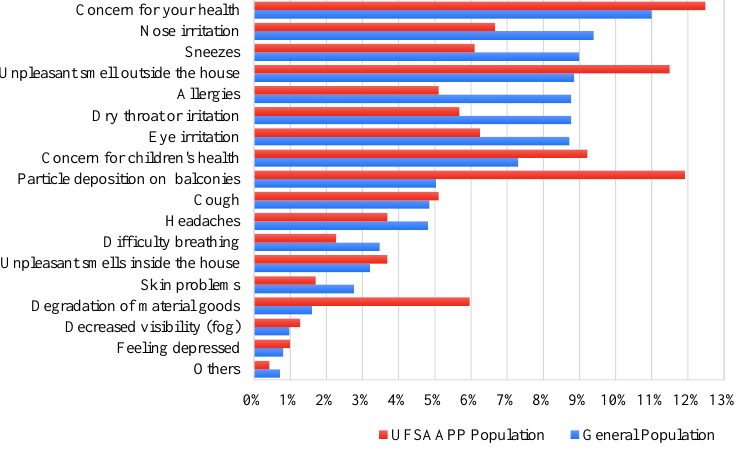
Figure 10. Perception of the impacts of air quality problems on the general and UFSAAPP populations. Both populations considered that air quality problems had an impact on their own health, with 11.0% of the general population and 12.5% of the UFSAAPP population re-